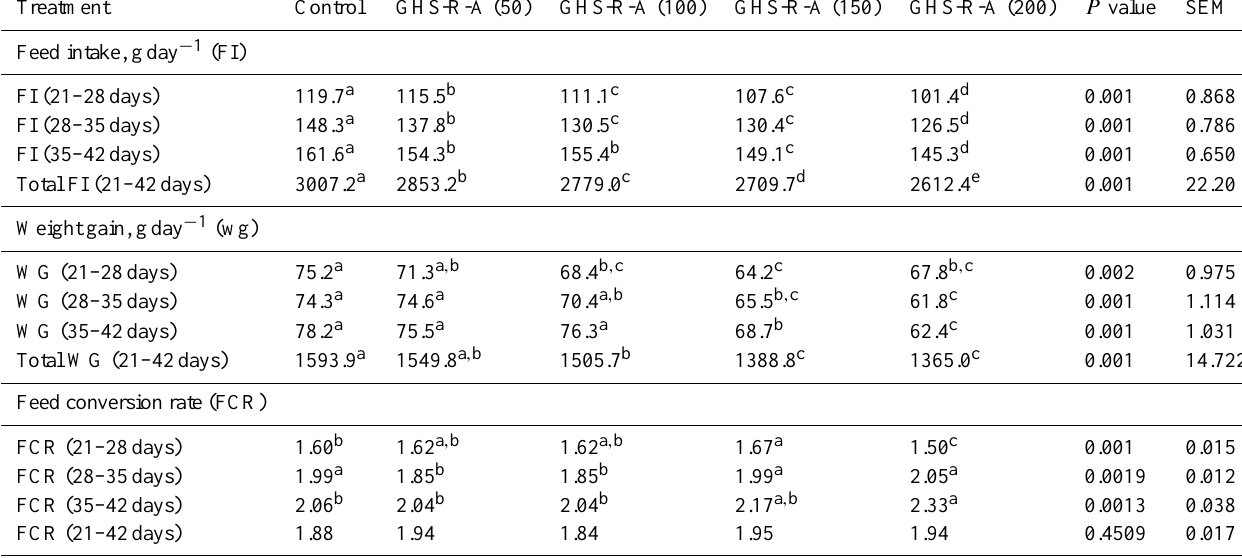
Table 2. Effects of peripheral GHS-R antagonist on performance in broiler chicks.